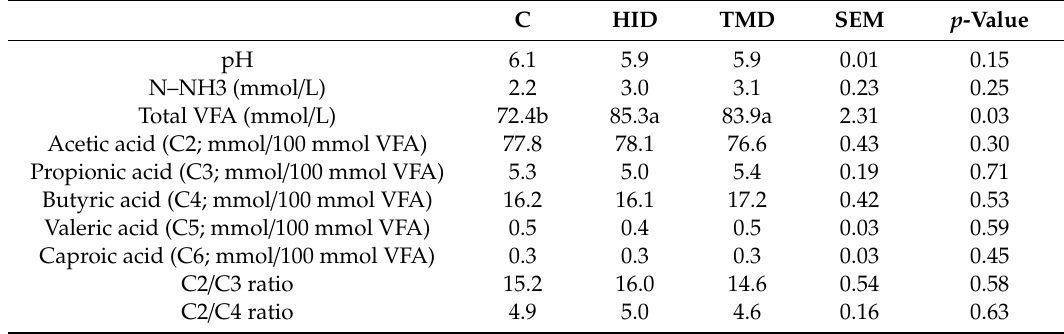
Table 4. E ff ect of lipid sources on cecal traits and fermentation parameters (n = 10 rabbits /